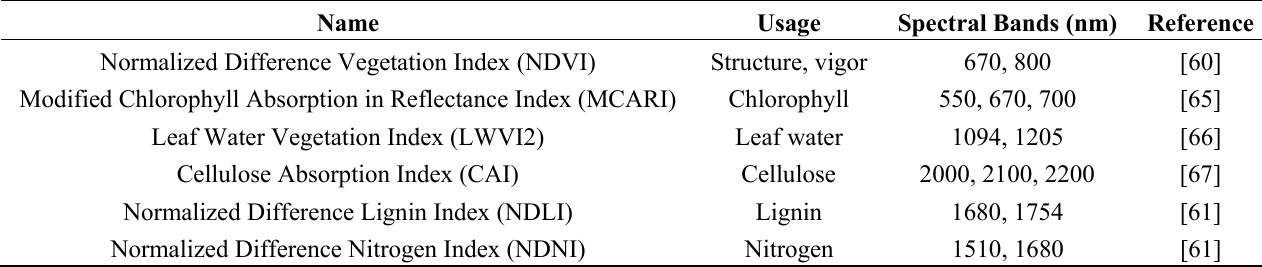
Table 1. Narrow band spectral indices used in the analysis, usage and spectral bands used